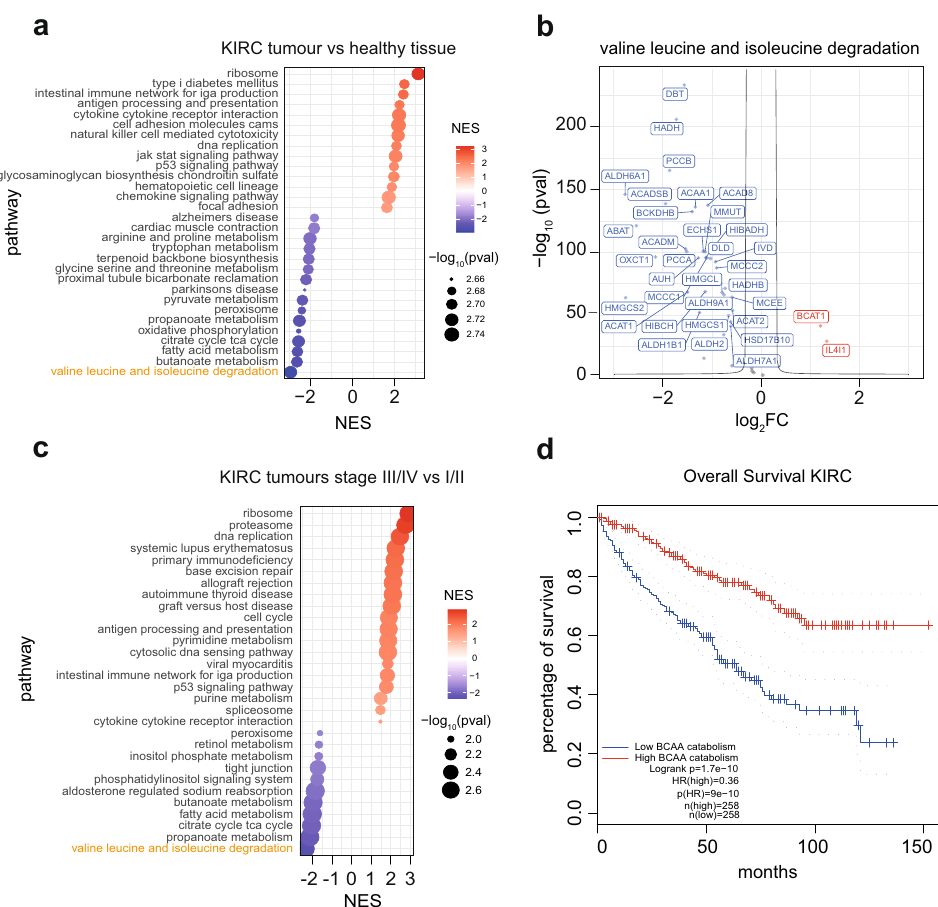
Fig. 1| Branched-chain aminoacidcatabolism issuppressedin KIRC.a Dotplot showingtheenrichedpathwaysrankedbysigni fi canceinKIRCtumorscomparedto renal healthy tissue obtained through GSEA analysis of RNA-seq data from TCGA. The dot size represents the signi fi cance expressed as – log 10 ( p -value). red dots= upregulated pathways, blue dots=downregulated pathways. NES normalized enrichment score. Statistics was calculated using moderated two-sided Student test, p -values werecorrectedwith Benjamini – Hochberg procedure. b Volcano plot showing the differential expression of genes that belong to KEGG “ Valine leucine and isoleucine degradation ” signature in KIRC tumors compared to renal healthy tissue.FCfold-change,red=upregulatedgenes,blue=downregulatedgenes. c Dot plot of the differentially enriched pathways in KIRC tumors comparing stage III/IV